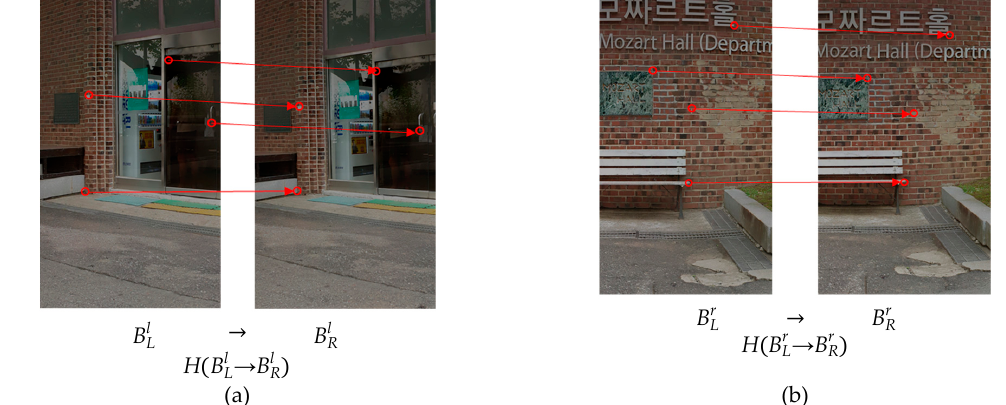
Figure 6. Homography matrixes H ( B Ll → B Rl ) and H ( B Lr → B Rr ) are calculated by applying the feature extraction algorithm and matching those feature points: ( a ) Example of feature matching when Homography matrix is H ( B Ll → B Rl ) ; ( b ) Example of feature matching when Homography matrix is H ( B Lr → B Rr ).